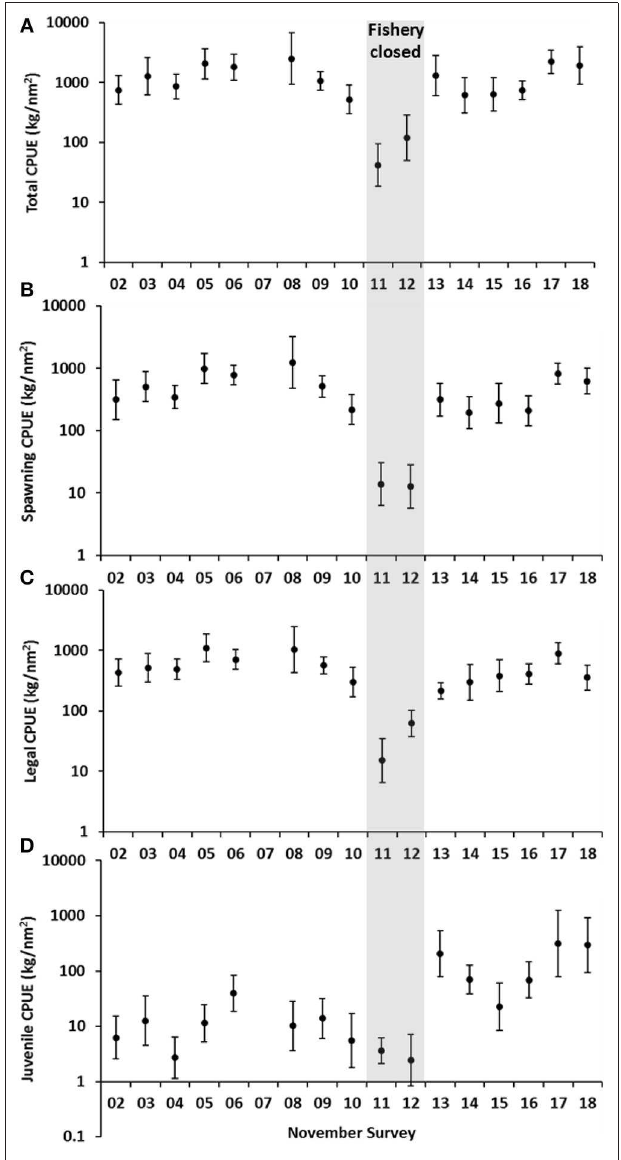
FIGURE 4 | Annual November fishery-independent survey catch rates (standardized mean ± 95% CI) presented on a log scale (A) total (all crabs) biomass levels (B) spawning (all females ≥ 110mm CW) (C) legal (all crabs ≥ 135mm CW) and (D) juvenile (females < 110mm CW, males < 100mm CW). Catch rates prior to 2011 represents fishery operating under input management system, 2011–2012 represents stock decline and recovery period, 2013–2018 represents recovery under a quota management